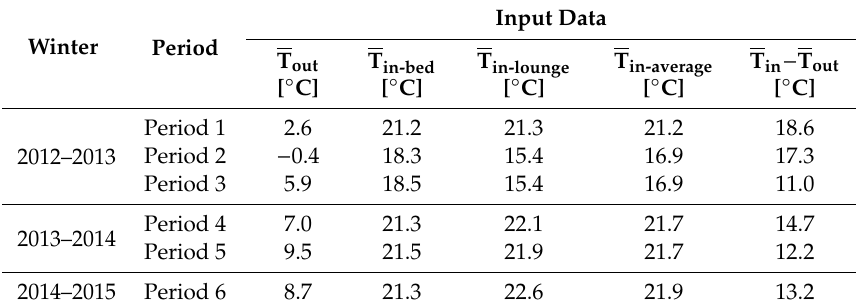
Table 6. Indoor temperature (bedroom, lounge and both average temperatures), outdoor temperature and temperature di ff erence for the analysed periods in